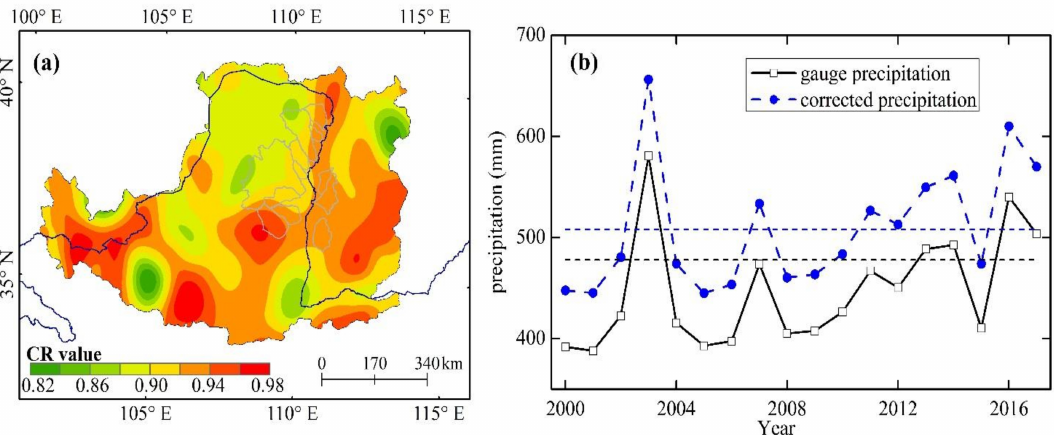
Figure 3. Bias correction to the precipitation over the Loess Plateau: ( a ) catch ratio distribution; ( b ) the changes in gauged and bias-corrected